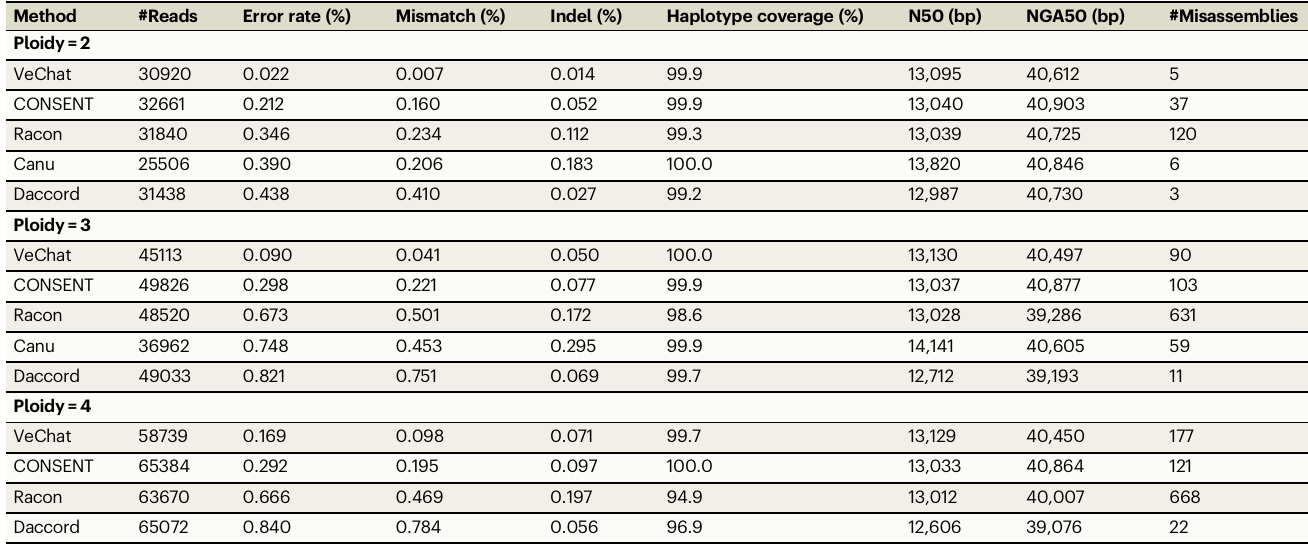
Table 2 | Error correction benchmarking results for simulated Oxford Nanopore reads of various polyploid genomes (ploidy = 2, 3, 4) Method